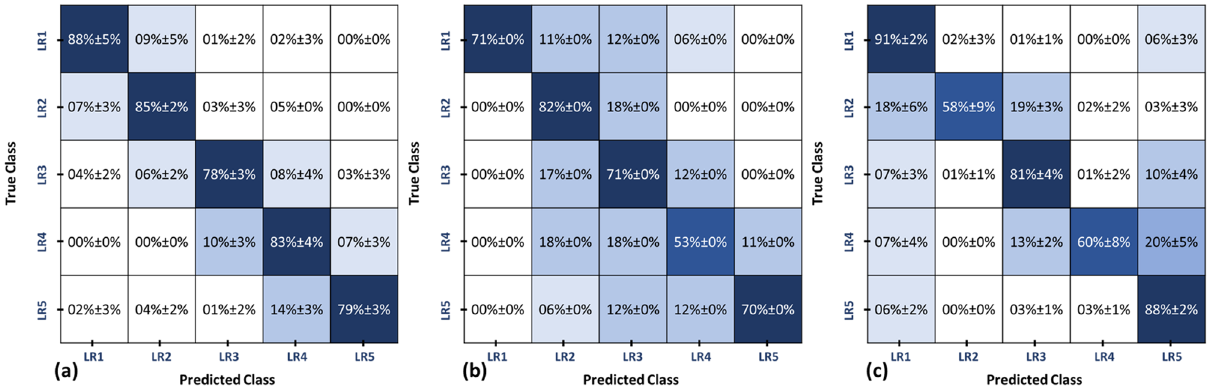
Figure 11. Confusion matrices comparing the final diagnostic performance for grading the tumors into (LR1, LR2, LR3, LR4, and LR5) by using ( a ) the proposed CAD sytem, (b) approach by Stocker et al. 18 , and ( c ) approach by Wu et al. 21